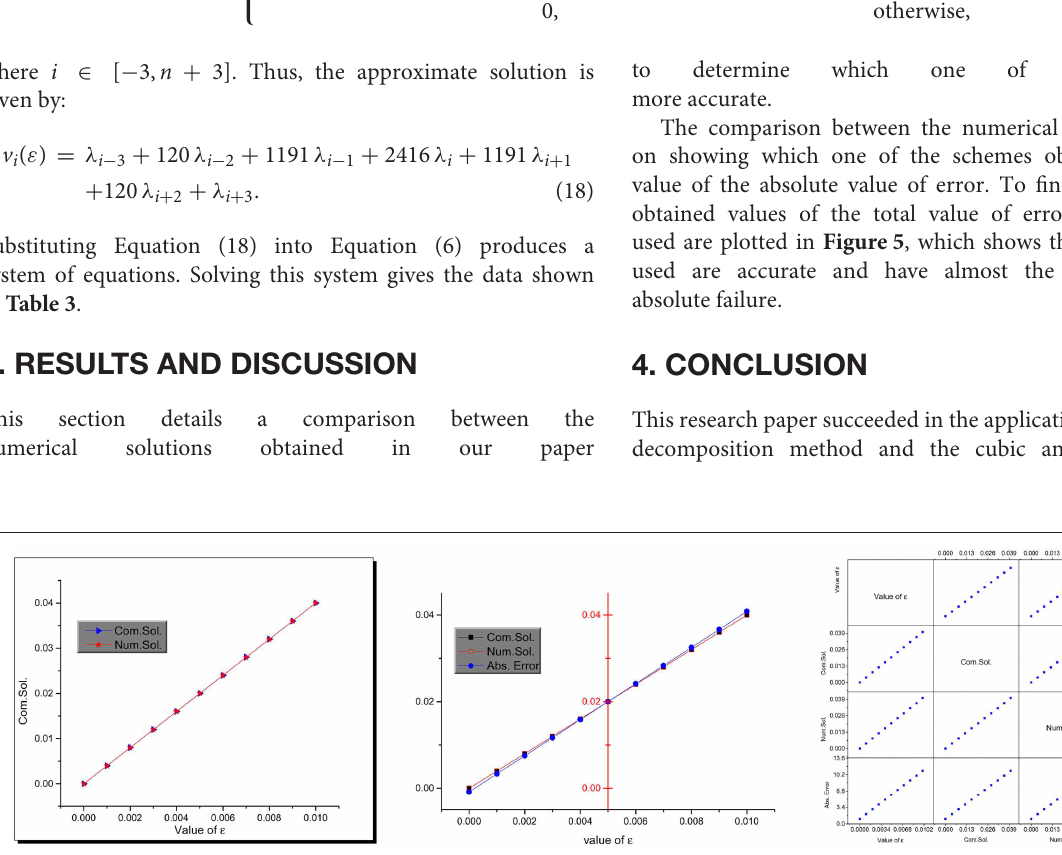
FIGURE 4 | Combined and scattering matrix plots of the computational, numerical, and absolute error values.